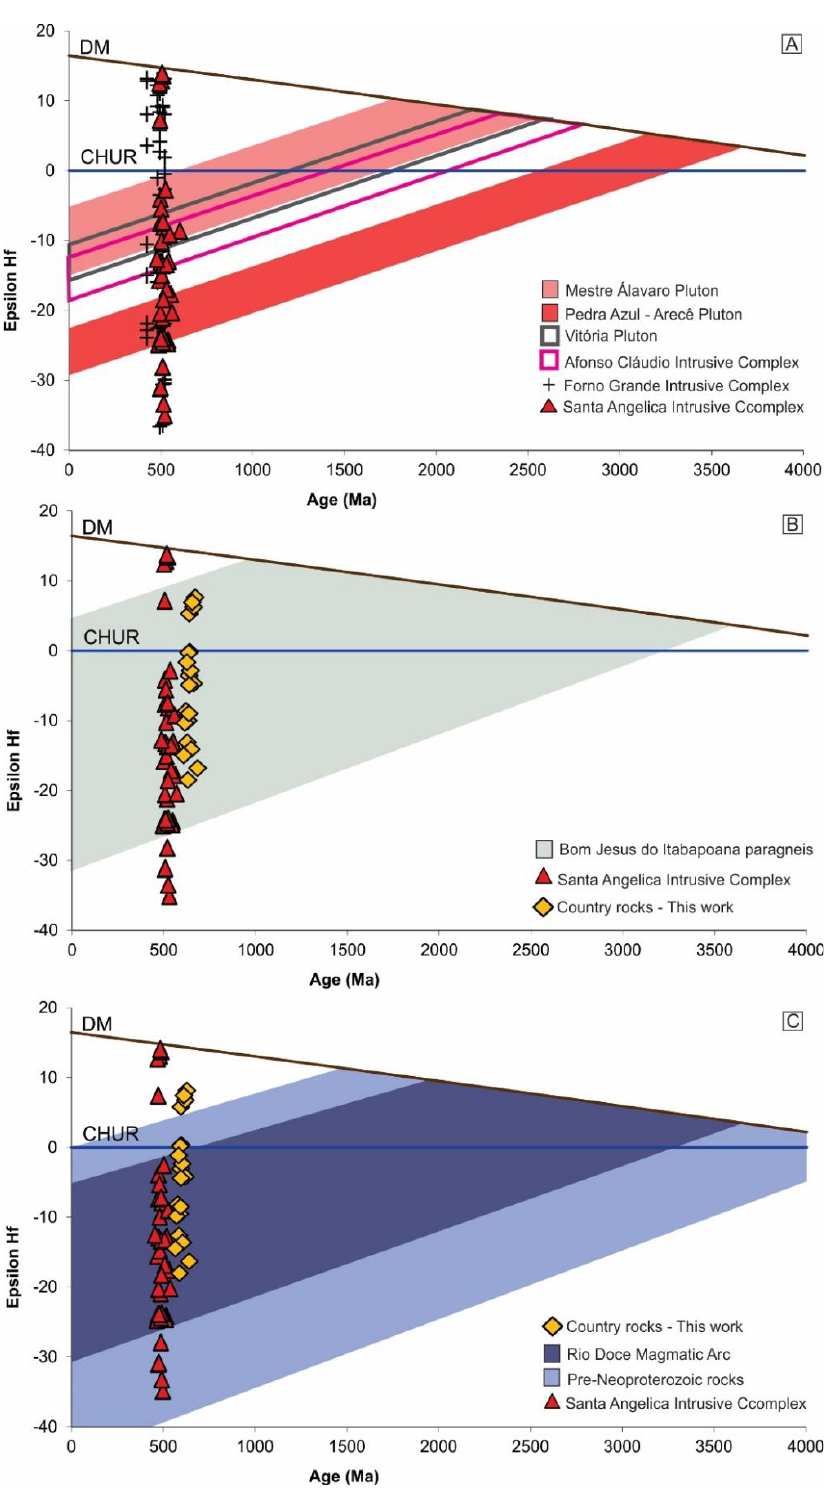
Figure 13. Hf isotopic evolution diagrams from chondritic reservoirs (CHUR) and the depleted mantle (DM). ( A ) presents the Ԑ Hf data from this work (for SAIC rocks) and data compiled from the work of [39 – 41] for the G5 supersuite units. ( B ) presents the Ԑ Hf values of this work for the SAIC and surrounding rocks (Muniz Freire orthogneiss), compared with the Ԑ Hf data obtained for the Bom Jesus do Itabapoana paragneisse, compiled from [44] and [32]. ( C ) shows the Ԑ Hf values of this work for the SAIC and surrounding rocks (Muniz Freire orthogneiss), compared to the rocks of the Rio Negro Magmatic Arc [7,34], and to the rocks of the Rhyacian-Orosian basement, whose data were compiled from [32,65].